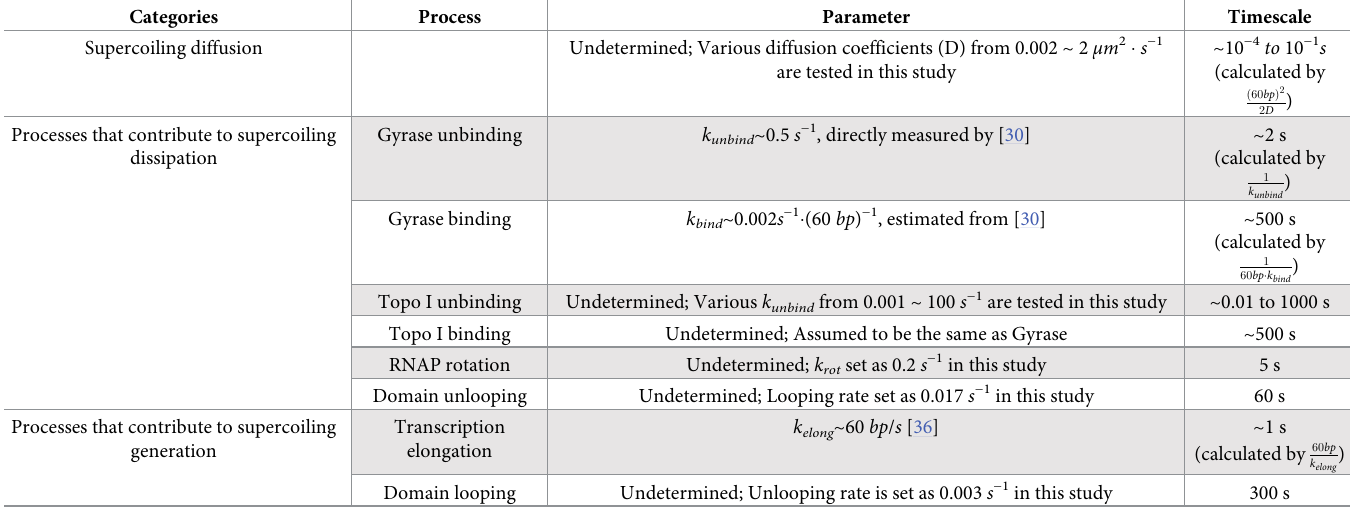
Table 1. Timescale for key processes in supercoiling dissipation and